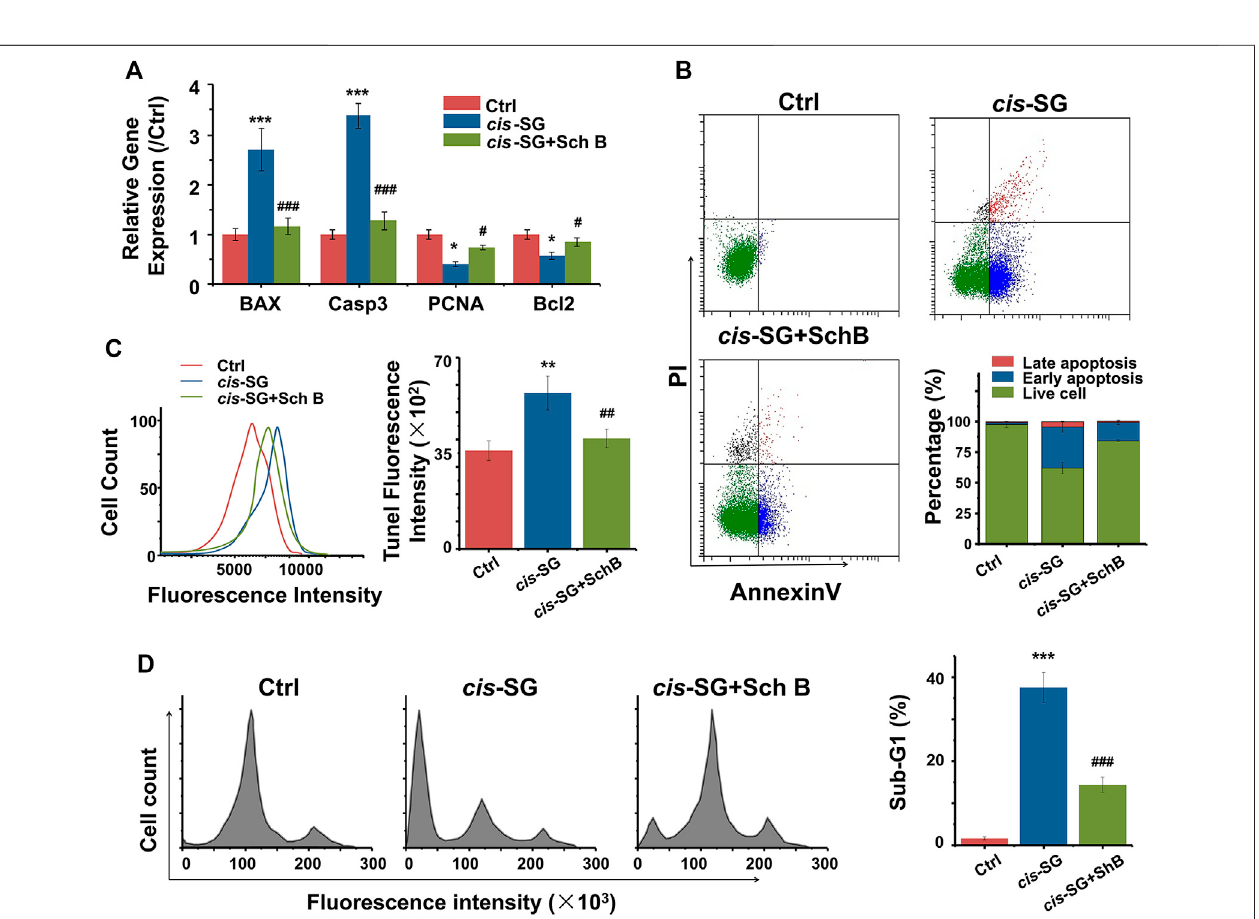
FIGURE 6 | Inhibiting apoptosis was involved in the blocking effect of mitochondria protective agents against cis-SG – induced hepatotoxicity on 3D cultured HepaRG organoids. (A) Sch B signi fi cantly reversed the cis-SG – induced abnormal expressions of mitochondrial dysfunction – related genes (BAX, Casp3, PCNA, and BCL2). (B) Flow cytometry assays of Annexin V/PI staining showed Sch B signi fi cantly decreased the proportions of early and late apoptosis induced by cis-SG . (C) TUNEL analysis showed Sch B signi fi cantly decreased cis-SG – induced late apoptosis. (D) Cell cycle – based apoptosis assay for HepaRG organoids showed that Sch B signi fi cantly reversed the cis-SG – induced DNA fragmentation. Values are expressed as the mean ± SD. * p < 0.05, ** p < 0.01, and *** p < 0.001, cis-SG – treated group vs control group; # p < 0.05, ## p < 0.01, and ### p < 0.001, cis-SG and Sch B co-treated group vs cis-SG – treated group.